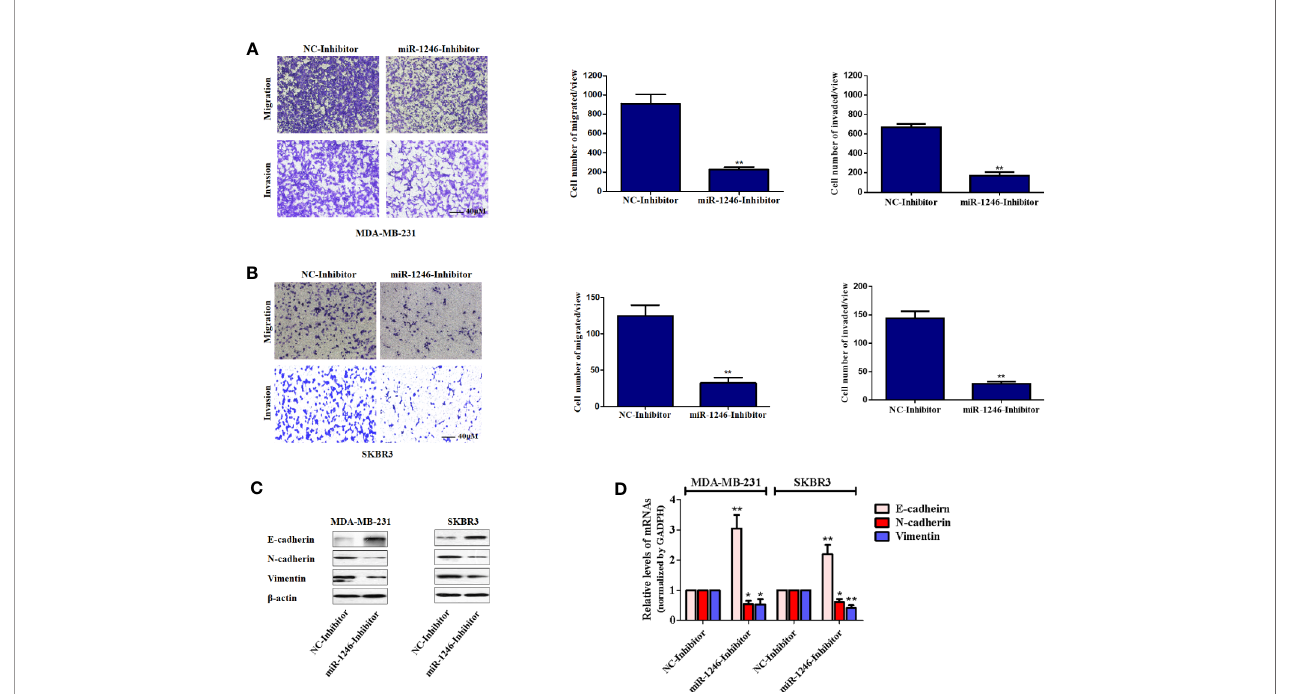
FIGURE 3 | miR-1246 inhibitor impairs the migration and invasion activities of breast cancer cells by repressing EMT. (A, B) Migration and invasion abilities of MDA- MB-231 (A) and SKBR3 (B) cells were determined using a Transwell assay. A total of 2x10 4 cells were seeded in Transwell chambers and incubated for 24 (h) Magni fi cation: 200X. (C) After cells were transfected with miR-1246 inhibitor or NC, the protein levels of EMT biomarkers E-cadherin, N-cadherin and Vimentin were determined using western blotting. (D) After cells were transfected with miR-1246 inhibitor or NC, the mRNA levels of EMT biomarkers E-cadherin , N-cadherin and Vimentin were determined using RT-PCR. Data are presented as mean ± SD, n=3. *P < 0.05 vs Control and **P < 0.01 vs.